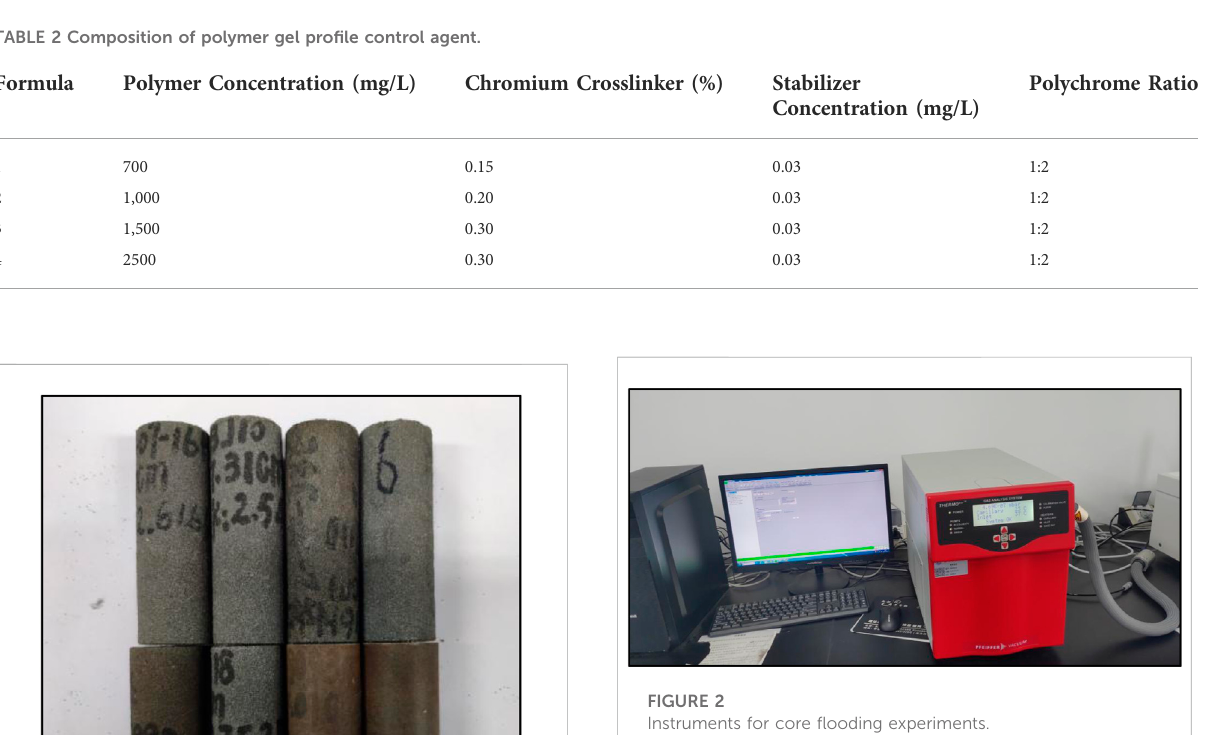
FIGURE 2 Instruments for core fl ooding